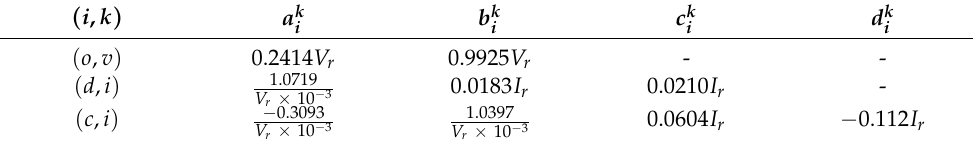
Table 1. VRB loss model